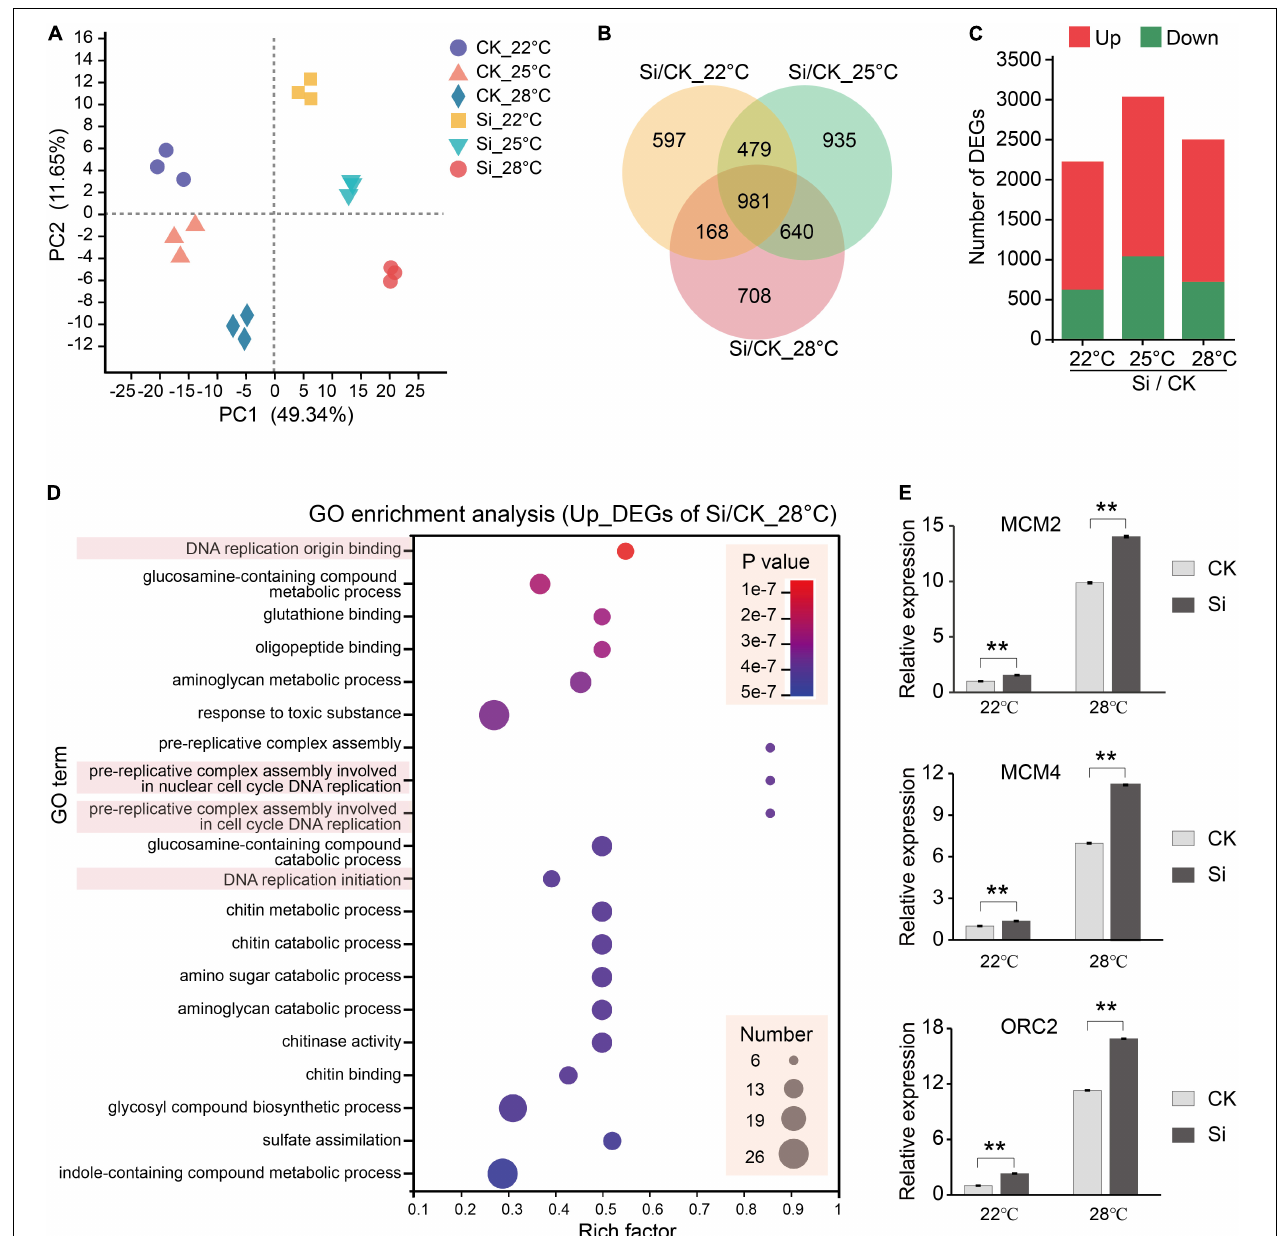
FIGURE 2 | Transcriptome analysis of the symbiotic response of Arabidopsis at different temperatures. Arabidopsis seedlings incubated with S. indica were grown for 7 days at 22, 25, and 28 ◦ C, and the seedling aerial parts were harvested for subsequent RNA-seq and RT-qPCR analysis. (A) Principle component analysis (PCA) of Arabidopsis transcriptome samples. (B) Venn diagrams showing the number of common and specific differentially expressed genes (DEGs) between S. indica -incubated (Si) and control (CK) samples at 22, 25, and 28 ◦ C. (C) The number of DEGs upregulated or downregulated during S. indica colonization at different temperatures. (D) Gene Ontology (GO) enrichment analysis of the upregulated DEGs at 28 ◦ C, which showed that DNA replication-related genes were highly enriched. GO enrichment analysis of other DEGs is shown in Supplementary Figure 2 . (E) The expression of the DNA replication-related genes MCM2, MCM4, and ORC2 was detected by RT-qPCR. Error bars indicate SE ( n = 4). Significance analysis of differences were performed by t -test (** P <